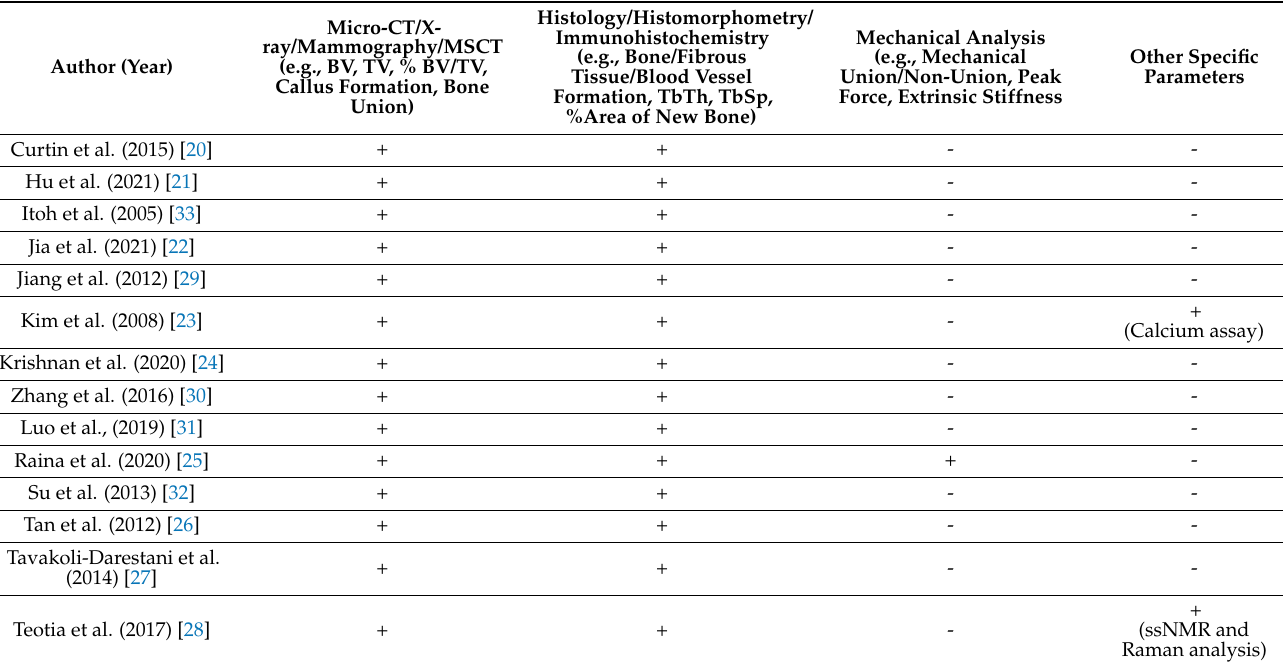
Table 2. Outcome parameters.